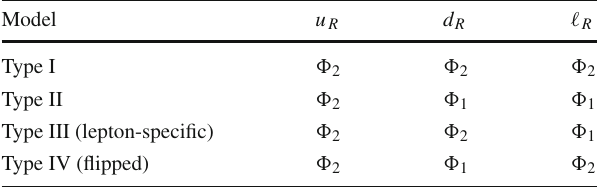
Table 3 Summary of which of the two Higgs doublet fields (cid:16) 1 , 2 is coupledtoup-typefermions( u R ),down-typefermions( d R )andcharged leptons ( (cid:9) R ) in the four Yukawa types of the